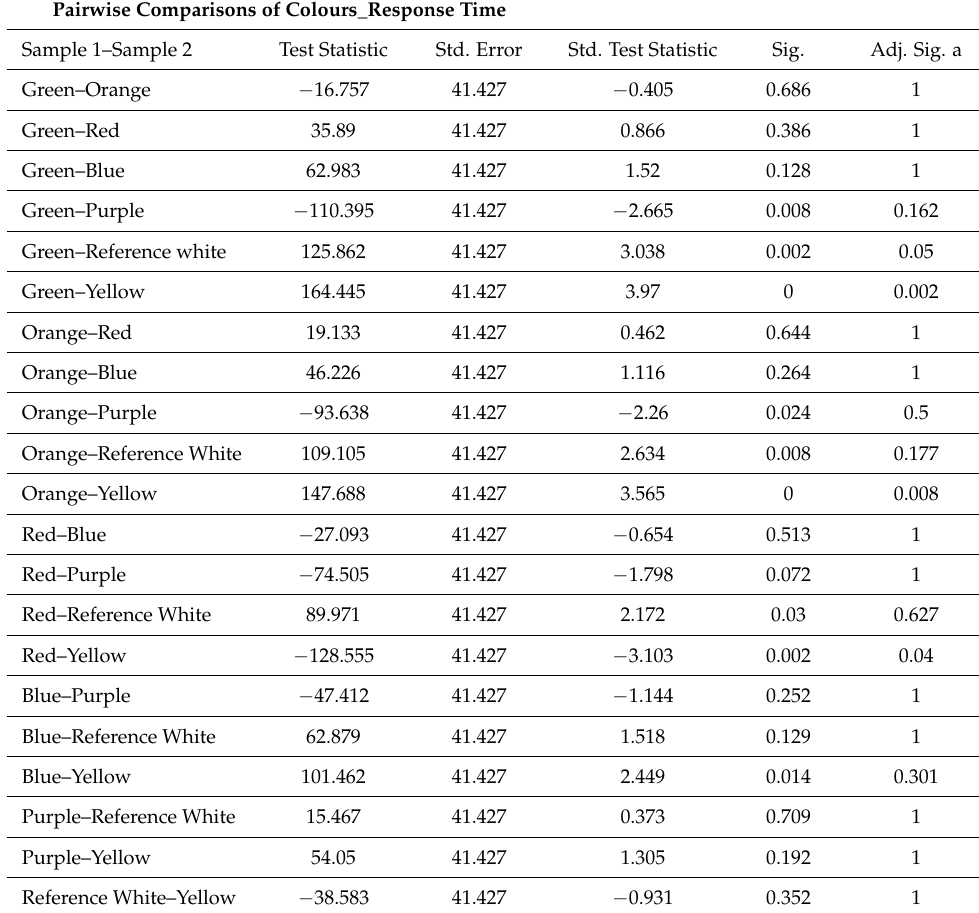
Table A12. Effects on response time (general effects).